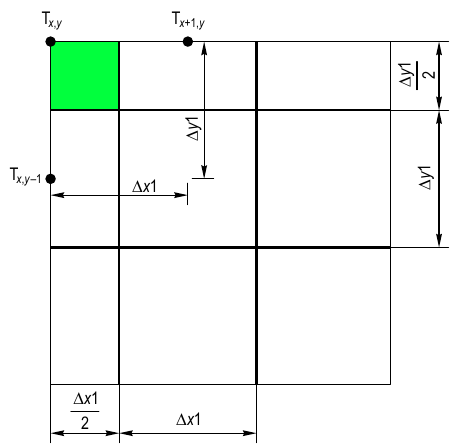
Fig. 3. Cell geometry for surface-boundary node Table 2. Classification and definition of surface